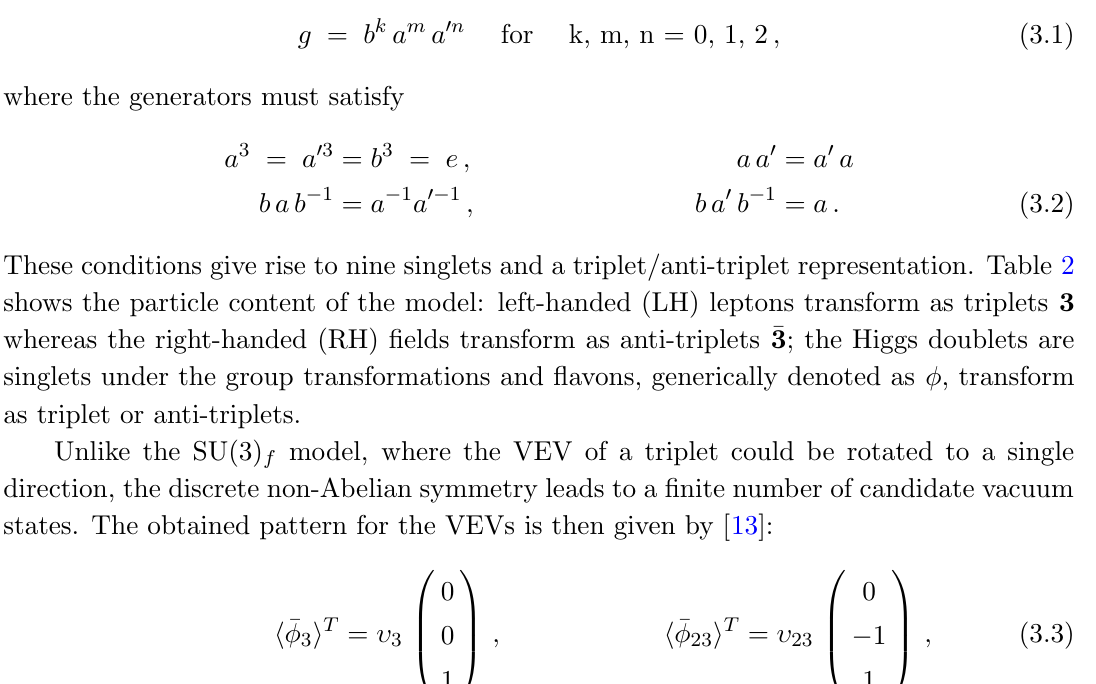
Table 2 . Transformation of the matter super(cid:12)elds under the (cid:1)(27) family symmetries. (cid:1)(27) is the simplest non-trivial group in the series (cid:1)(3 N 2 ), a discrete subgroup of SU(3) that can be de(cid:12)ned in terms of the semi-direct product ( Z of the group ( g ) can be written in terms of the generators of Z